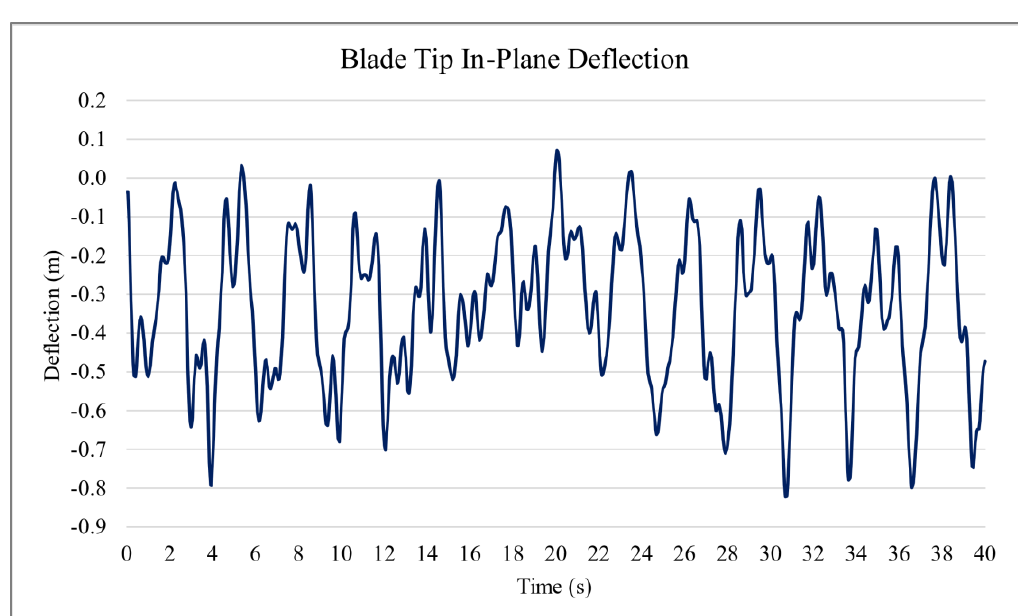
Figure 13. Blade Tip In-Plane Deflection - 50% Turbulence